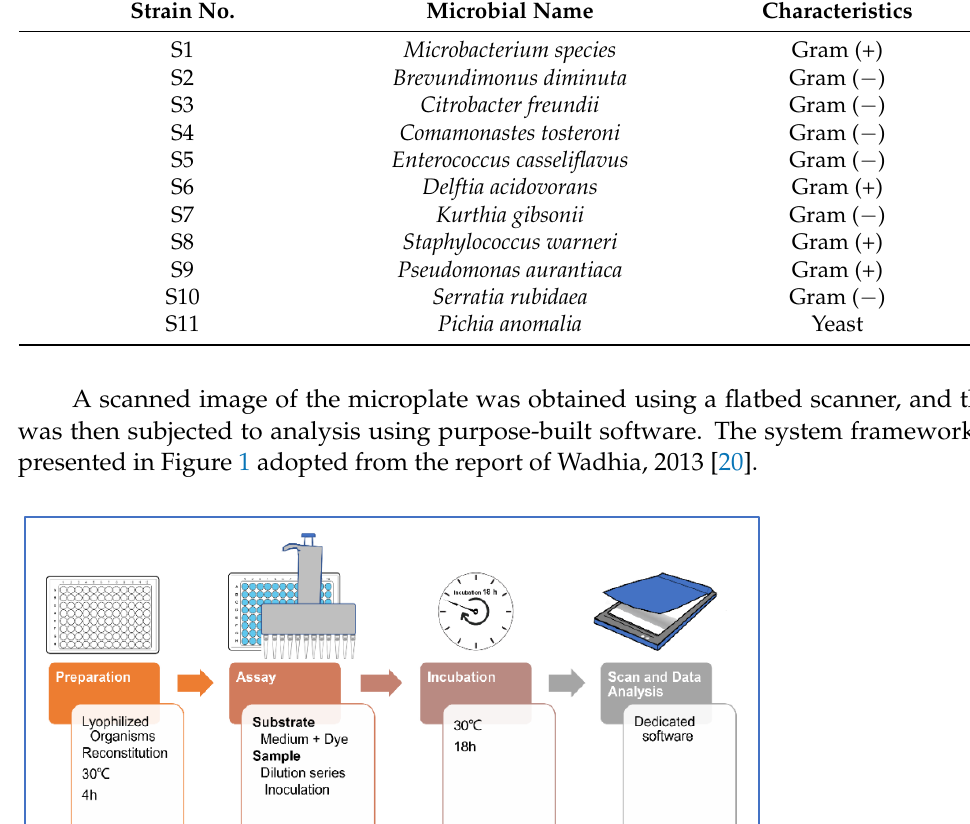
Table 1. Microorganism applied in MARA. Strain No.